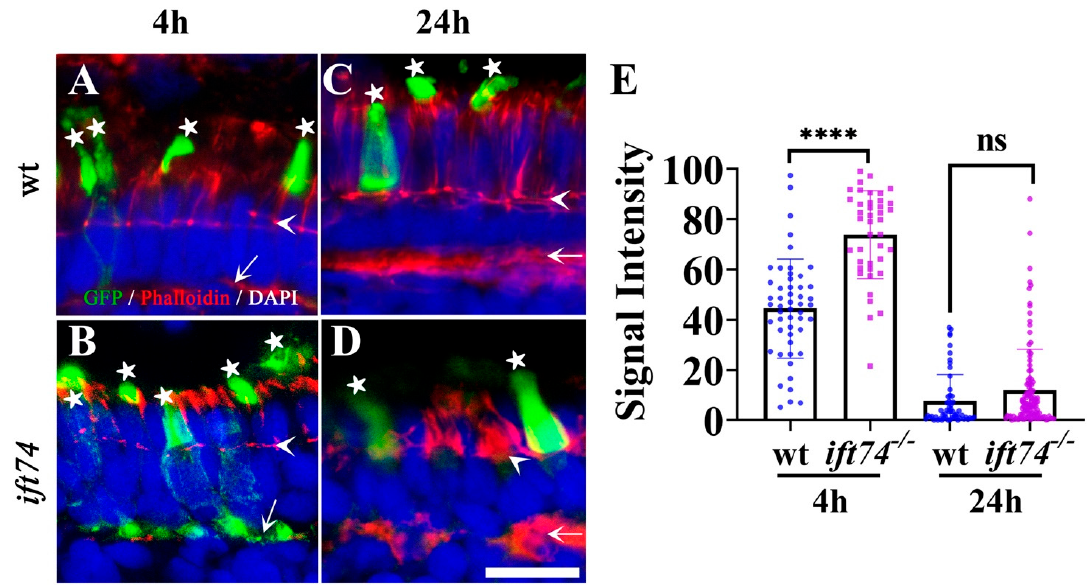
Figure 5. Opsin transport analysis in ift74 mutant. ( A – D ) Representative confocal images of transverse cryosections through the central retinae of wild-type and ift74 mutant larvae at 4 and 24 h after heat-shock induction. The subcellular distribution of the GFP-CT44 (green) was evaluated. Sections were counterstained with phalloidin (red) to visualize the outer limiting membrane and the outer plexiform layer. Cell nuclei were stained with DAPI in blue. ( E ) Relative GFP fluorescence intensity in the cell bodies measured between the outer limiting membrane and the outer plexiform layer. Asterisks indicate outer segments; arrowheads indicate the outer limiting membrane and arrows indicate the outer plexiform layer. Scale bar: 10 μ m. **** p < 0.0001, ns, no significant.